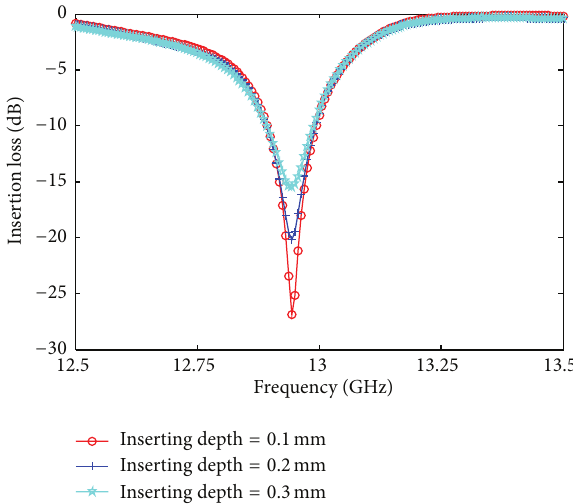
Figure 4: Changes of attenuation with different depths of absorbing